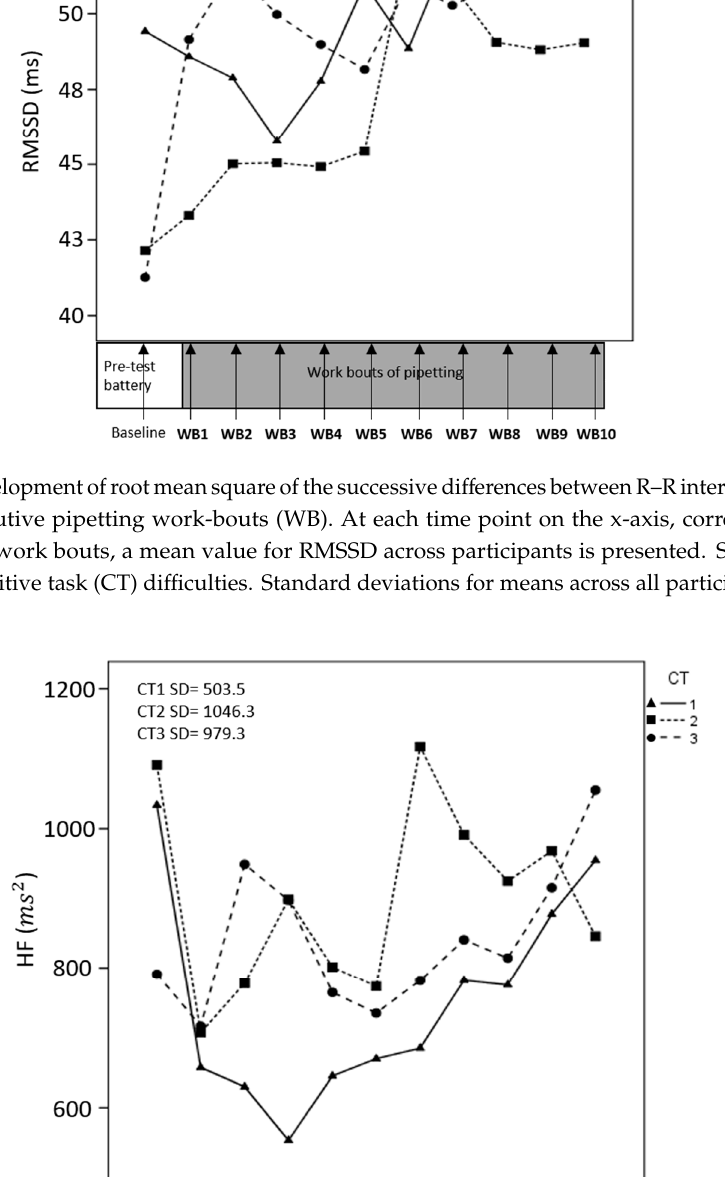
Figure 6. Development of High Frequency spectral power (HF) across consecutive pipetting work bouts (WB). At each time point on the x-axis, corresponding to the pipetting work bouts, a mean value for HF across participants is presented. Separate lines illustrate cognitive task (CT) difficulties. Standard deviations for means across all participants and all time points.